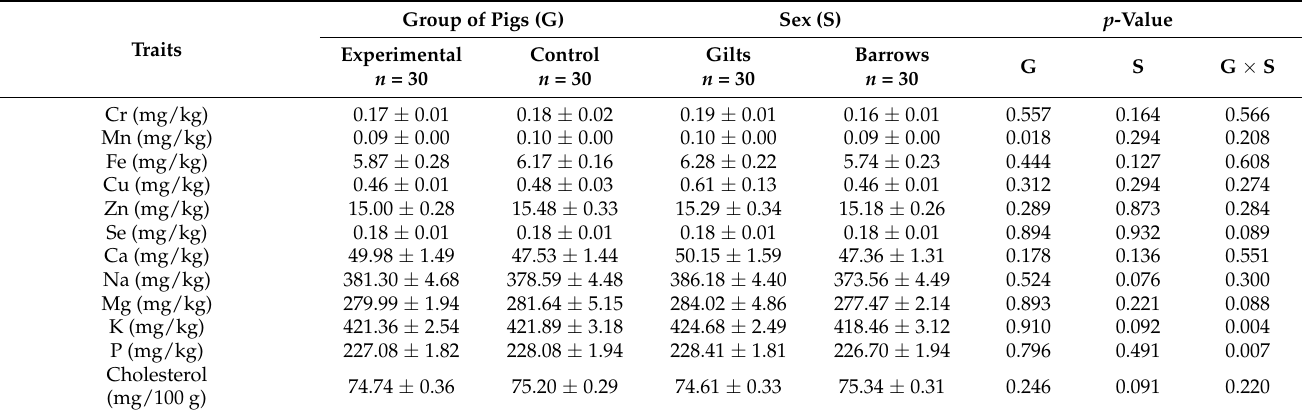
Table 7. Microelements, macroelements, and cholesterol in the LL